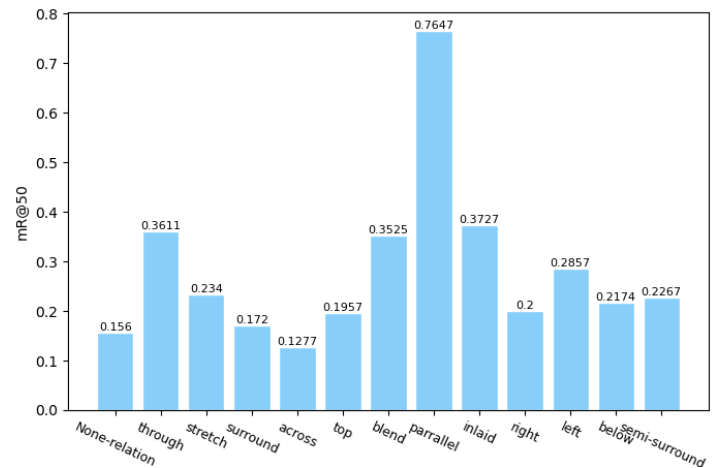
Figure 5. Prediction results for each type of relational predicate. Table 2. The performance of RSSGG_CS on the three subtasks of scene graph generation. PreCl PhaCl